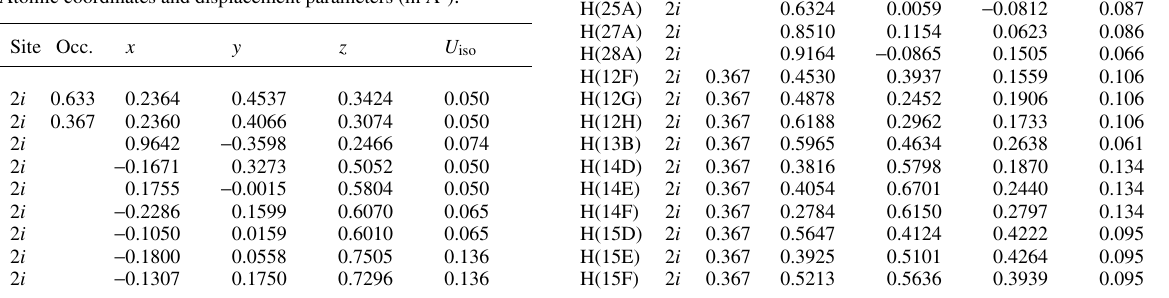
Table 2. Atomic coordinates and displacement parameters (in Å 2 ) .